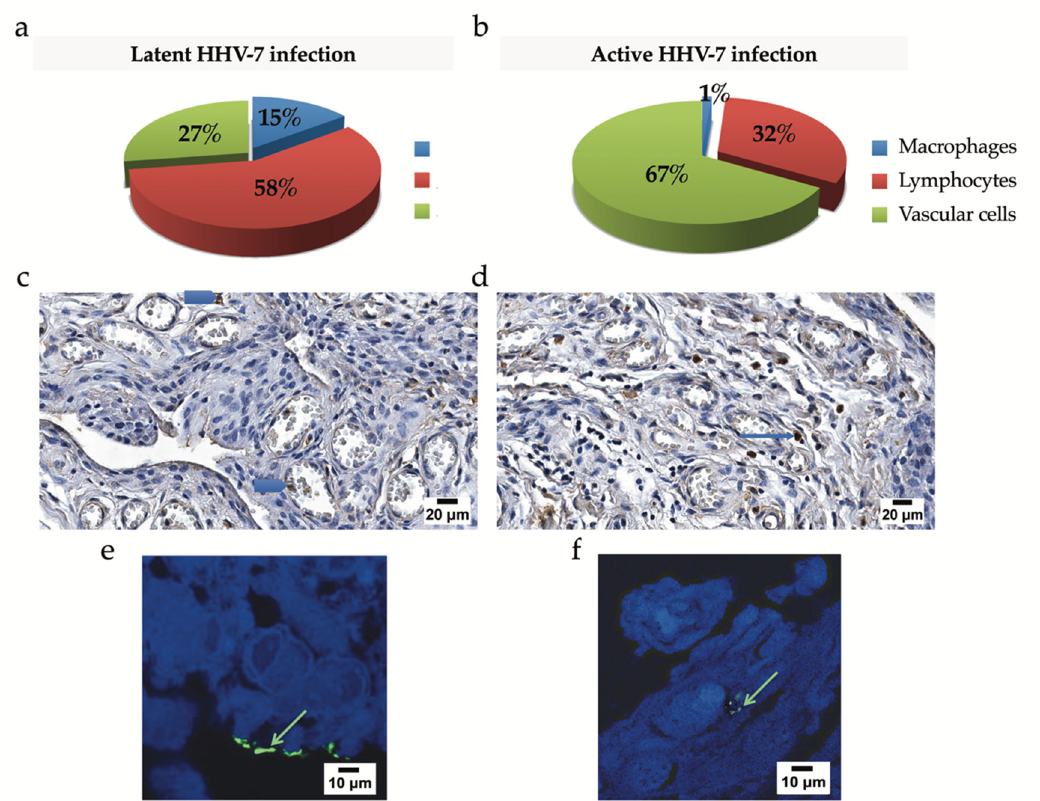
Figure 7. The assessment of the HHV-7 antigen in the synovial membrane. ( a , b ) Frequencies of HHV-7-positive lymphocytes, vascular endotheliocytes, and macrophages based on immunohistochemistry data and compared for patients presenting with latent ( a ) and active infection ( b ). When assessed quantitatively, HHV-7-positive lymphocytes constituted a significant cellular fraction affected by the virus in latent HHV-7 infection and reached 58%. In contrast, vascular endotheliocytes forming the innermost layer of vascular beds appeared the most vulnerable in active HHV-7 infection, demonstrating a 67% involvement. There was a significant difference found between the distribution of HHV-7-positive endotheliocytes estimated for latent and active HHV-7 infections ( p = 0.028). ( c ) Immunohistochemical detection of the HHV-7 antigen in the case of latent HHV-7 infection. Intravascular HHV-7-positive cells recognized by brown coloration (blue arrowheads) localized in the lumen of congested blood vessels. Cellular nuclei counterstained with Mayer’s hematoxylin (blue). Scale bar: 20 µ m. ( d ) Numerous perivascular (blue arrow) and vascular endothelial HHV-7-positive cells localized in the sublining layer. Cellular nuclei counterstained with Mayer’s hematoxylin (blue). Scale bar: 20 µ m. Detection of the tegument protein pp85 of HHV-7 by immunofluorescence (HHV-7-immunopositive products, green), confocal microscopy; 1% toluidine blue was added to the fluorophore, and it resulted in near infra-red fluorescence in the cellular cytoplasmic compartment. Green arrows indicate the presence of viral protein at the top of synovial macrophages ( e ) and within the cell cytoplasm ( f ). Scale bar: 10 µ